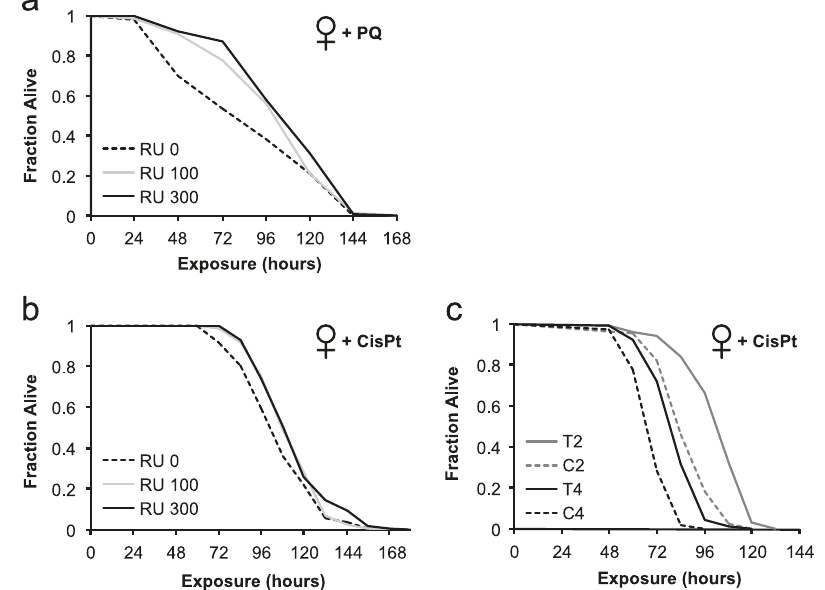
Fig. 4 Overexpression of dPrp19 promotes resistance to genotoxic agents in female fl ies . a Induction of the dPrp19 cassette with either 100 ( gray line ) or 300 µg/ml RU486 ( black, solid line ) signi fi cantly increases resistance to 20 mM paraquat (methyl viologen) in females ( Tub GS-Gal4 > UAS- dPrp19-1 ) as compared to the uninduced control ( black, dashed line ; see Supplementary Table 3 for statistics). b Resistance of females ( da GS-Gal4 > UAS- dPrp19-2) to genotoxic stress induced by treatment with 400 µg/ml cisplatin was improved signi fi cantly by dPrp19 induction at 300 µg/ml RU486; the intermediate induction level of 100 µg/ml RU486 was not signi fi cant after Bonferroni correction (see Supplementary Table 4 for statistics). c Females with constitutively active dPrp19 expression (T2: Tub- Gal4 > UAS- dPrp19 -2 in gray; T4: Tub- Gal4 > UAS- dPrp19 -4 in black ) showed signi fi cantly improved resistance to cisplatin relative to controls (C2: TM6 Sb ; UAS- dPrp19 -2, in dashed gray ; C4: TM6 Sb ; UAS- dPrp19 -4, in dashed black line ; see Supplementary Table 4 for statistics)